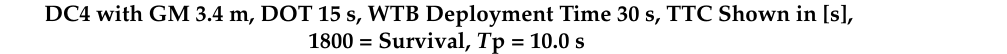
Table 4. Damage Case 4 with (red) and without (black) deploying the WT barrier on the trailer deck in beam seas.